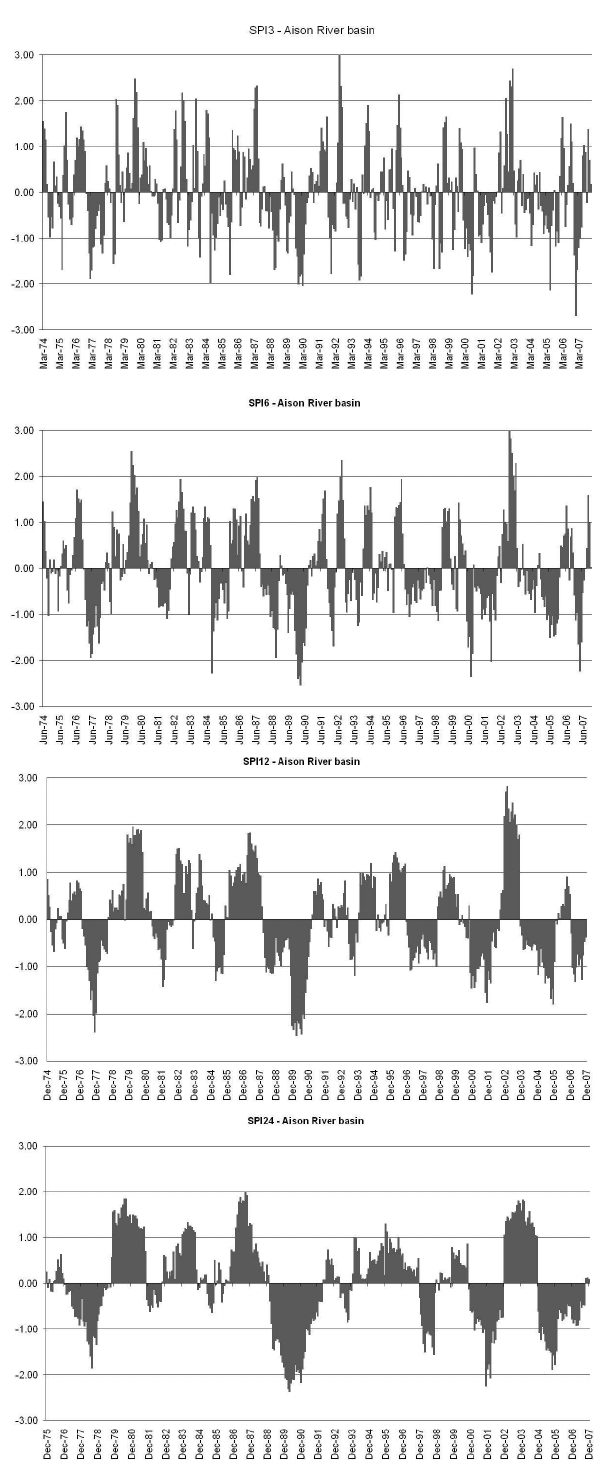
Figure 2. SPI values of variable time scales, for the Aison River basin. 3 Fig. 2. SPI values of variable time scales for the Aison River